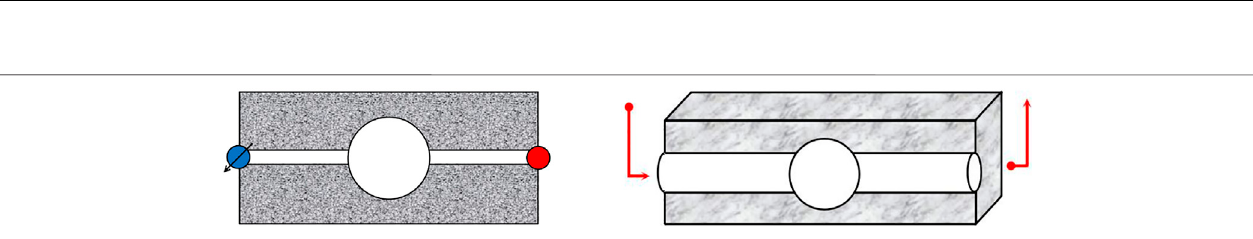
FIGURE 8 | Tracer output curve of interwell fracture series cavity under different parameters. (A) different b ( l =200 m, V c =100 m 3 , Q =20 m 3 /d) (B) different l ( b =5000 μ m, V